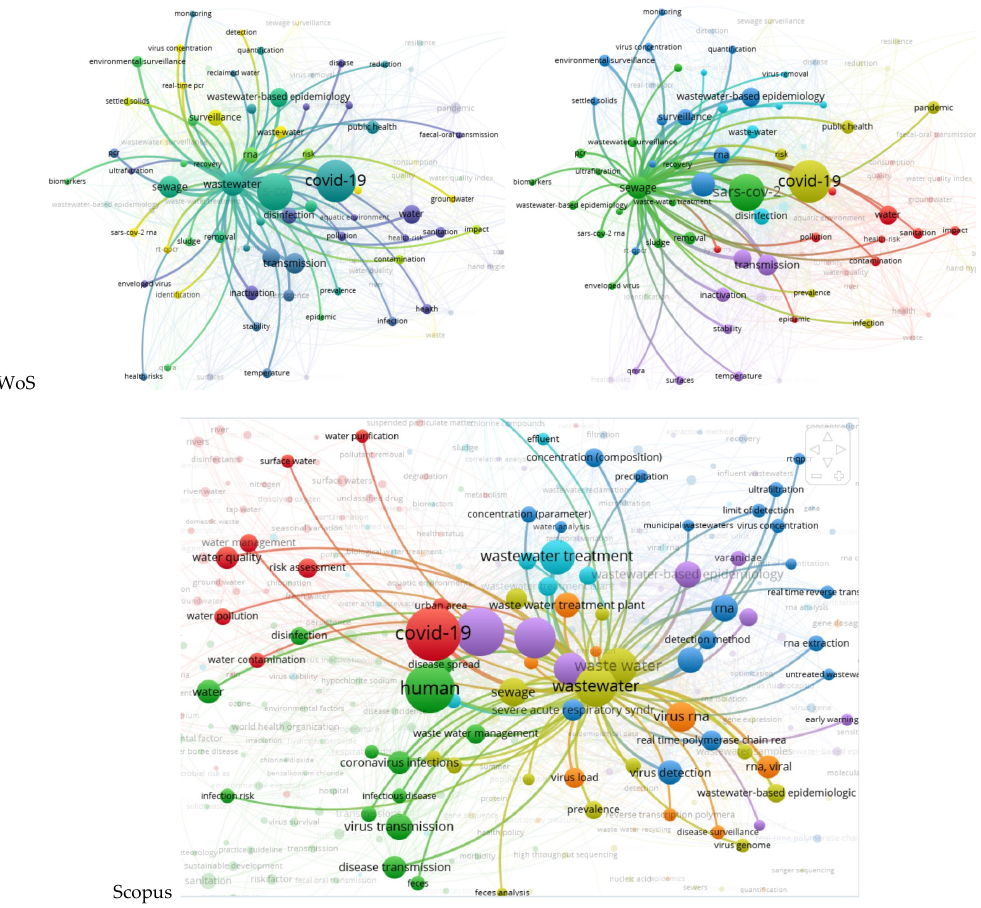
Figure 3. Co-occurrences for wastewater and sewage.